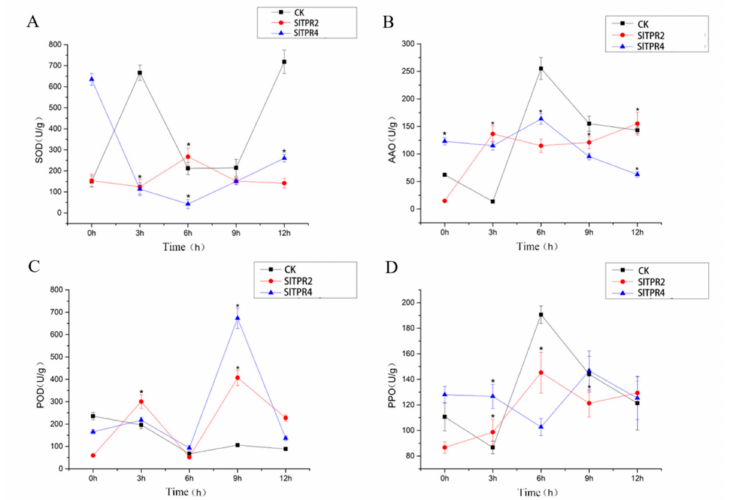
Figure 7. Effects of ABA stress on the SOD ( A ), AAO ( B ), POD ( C ), PPO ( D ) of control and SlTPR2 , SlTPR4 silenced tomato. Error line indicate the standard deviation of three independent biological replicates. ANOVA was used for significance analysis. “*” represents a significant difference between the data point and control ( p <